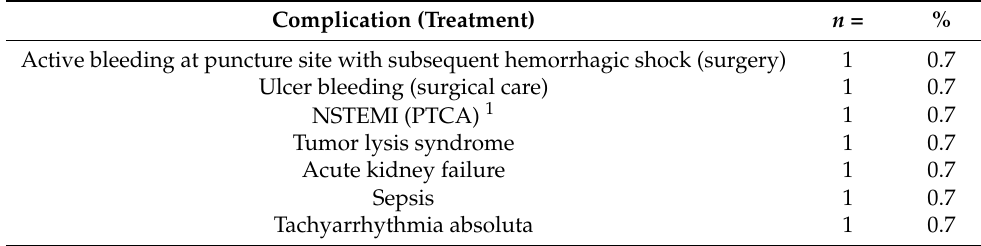
Table 4. Further CTCAE grade 3–4 non-hematotoxic and non-hepatotoxic complications after 145 percutaneous hepatic perfusions (PHPs) in 66 patients.